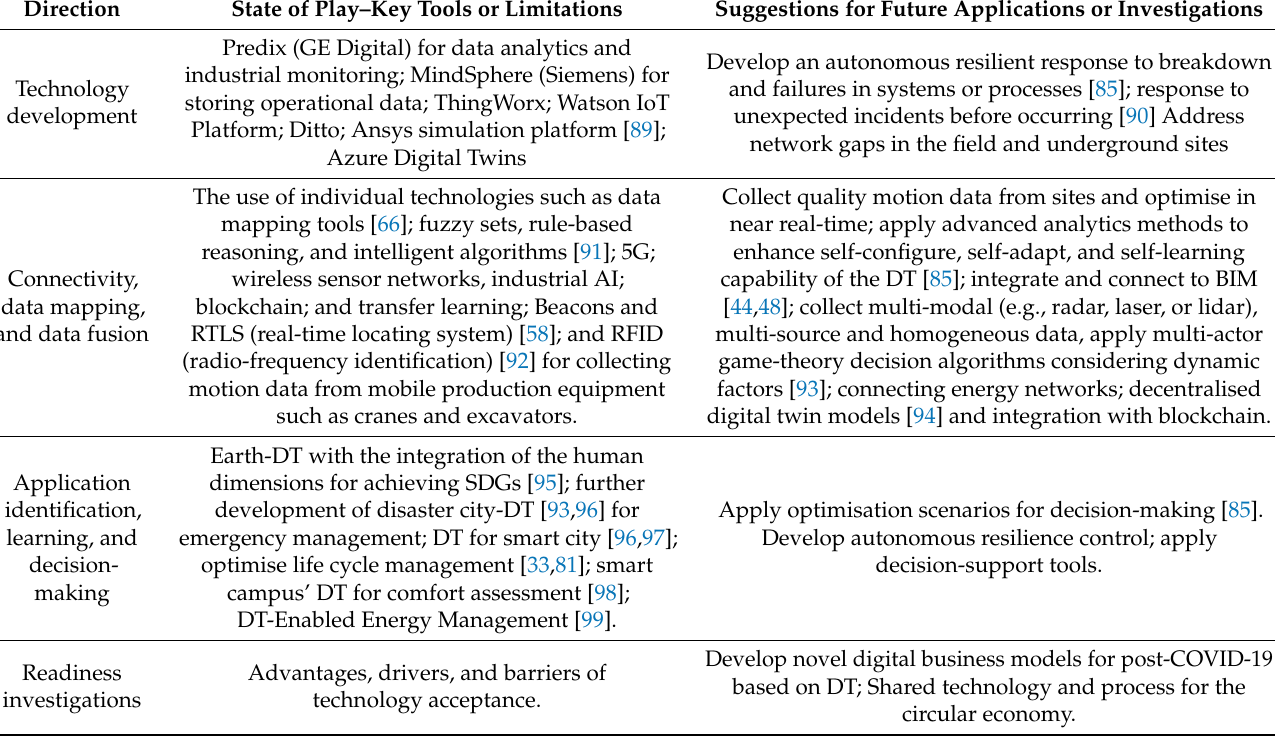
Table 2. State of play and suggestions for future investigations and application